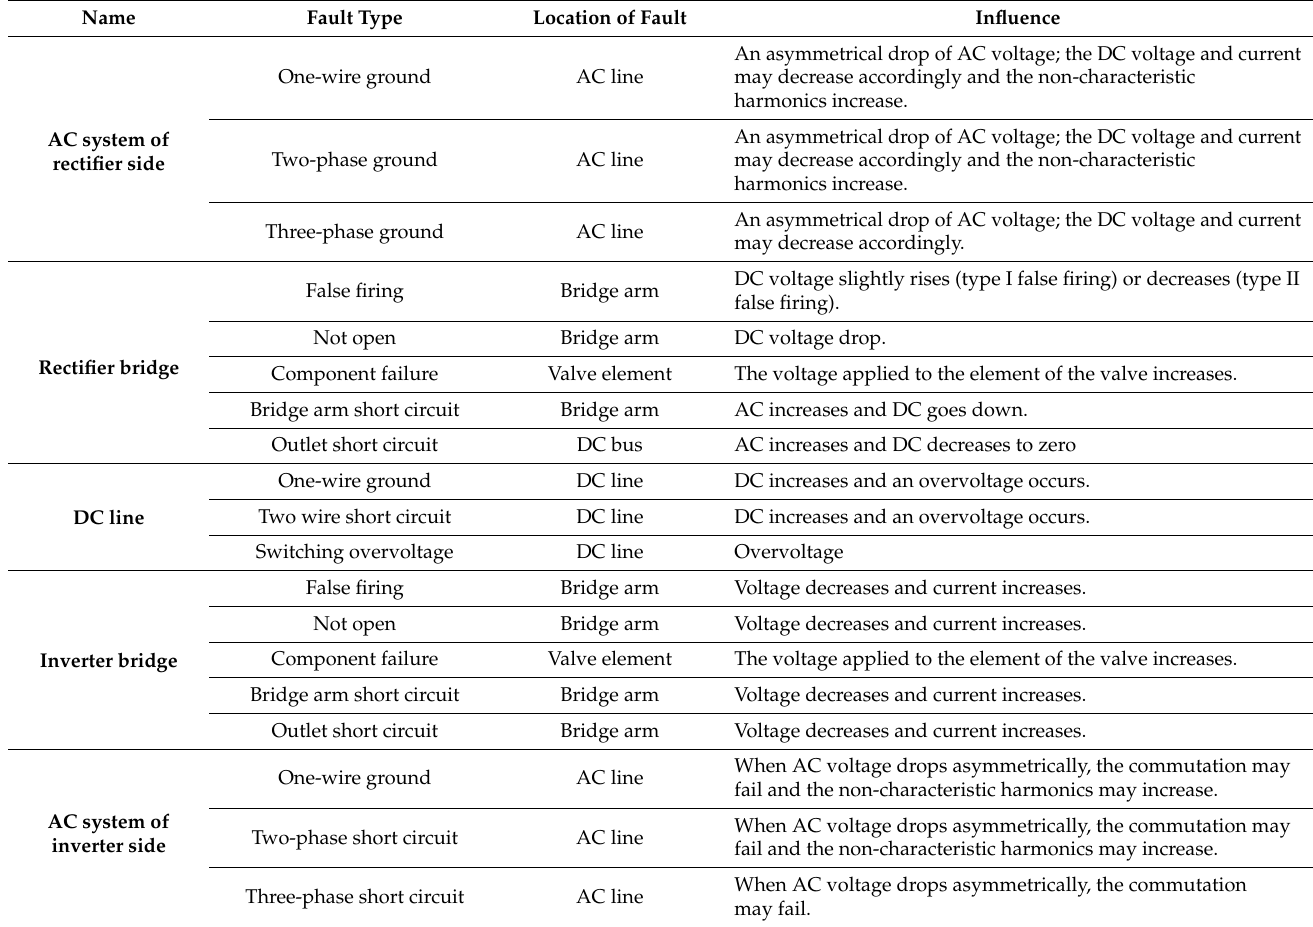
Table 3. Various faults and effects of HVDC transmission